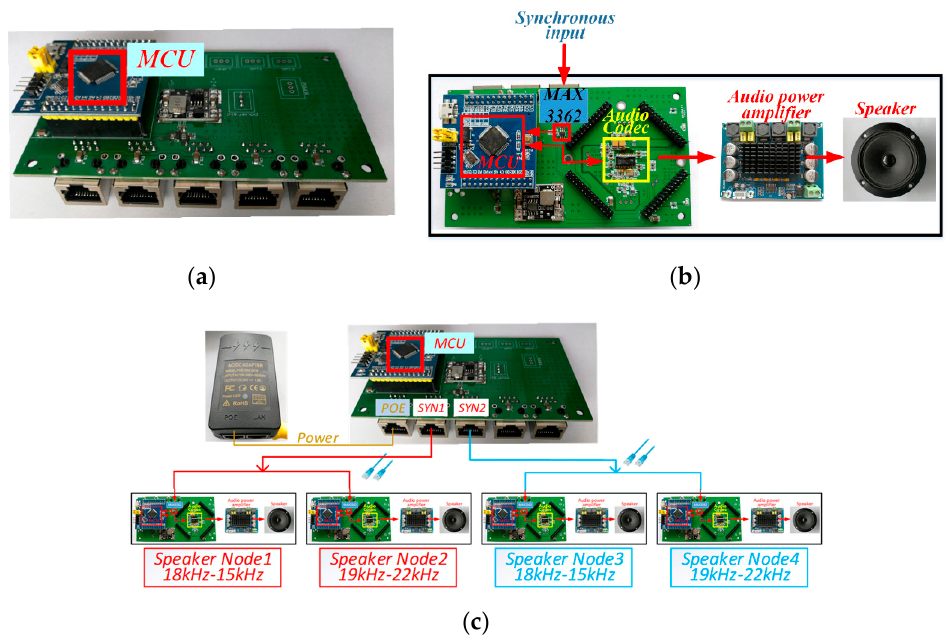
Figure 2. Diagram of the system hardware. ( a ) Synchronous node; ( b ) speaker node; ( c ) diagram of node connection.